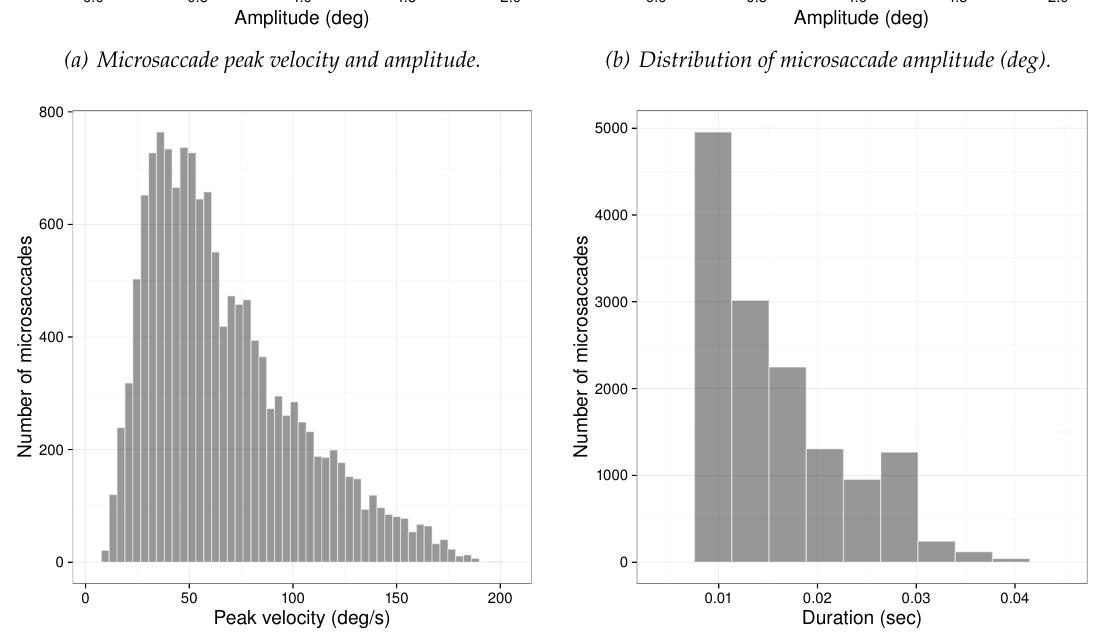
Figure 8 . Experiment 2. Distribution of microsaccade amplitude (b), peak velocity (c), and duration (d). Figure (a) depicts the nonlinear relationship between peak velocity and amplitude with different function fits. Data were captured at 300